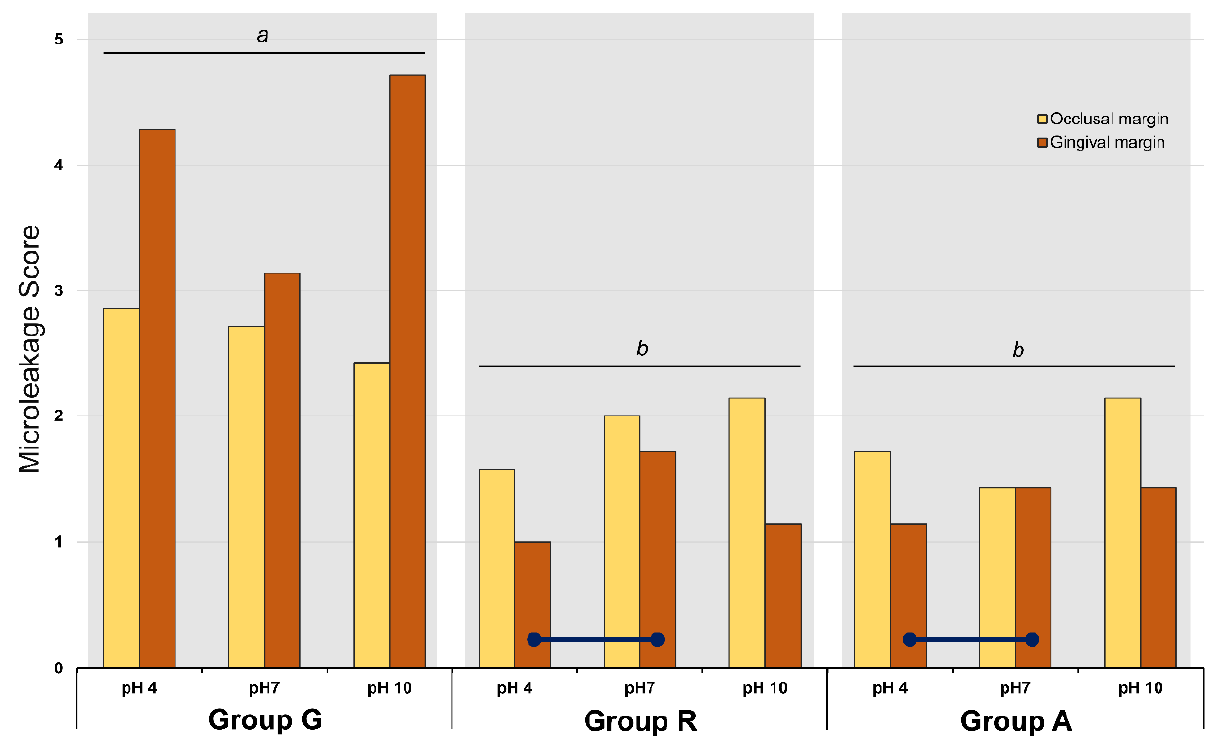
Figure 4. Mean scores of microleakage analysis of the experimental groups. Different lower letters on top of the long bar denote statistically significant difference among groups ( p = 0.001). Navy lines mean statistically difference between the marked sub-groups ( p < 0.05). Table 3. Microleakage score